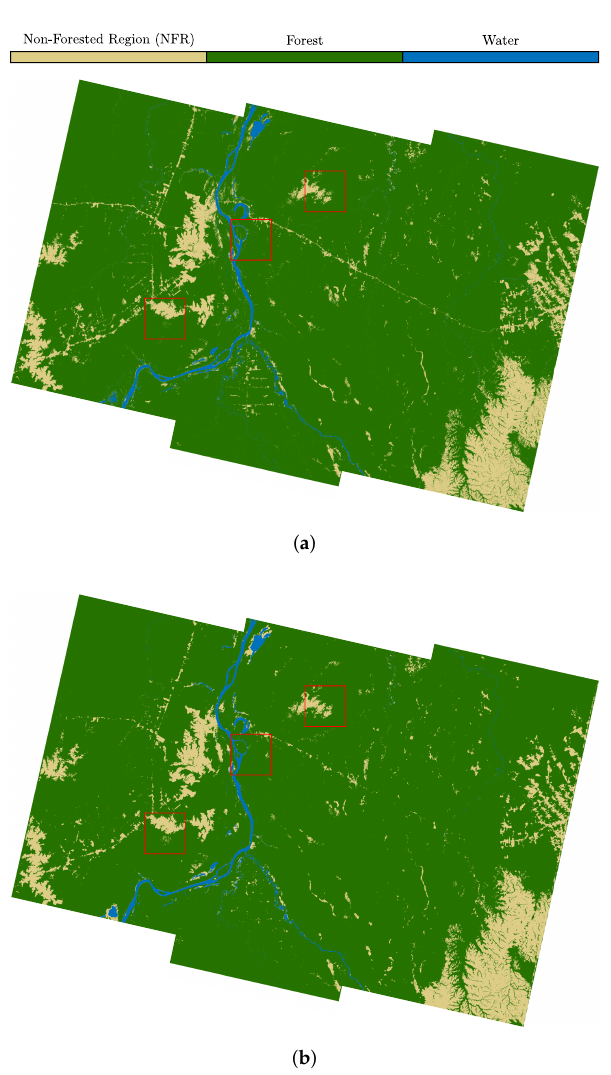
Figure 7. Comparison of ( a ) the FROM-GLC reference map and ( b ) the prediction for case X from the area in TS1 083 . We selected three image patches of size 384 px × 384 px to perform a detailed visual inspection for all the 10 cases under